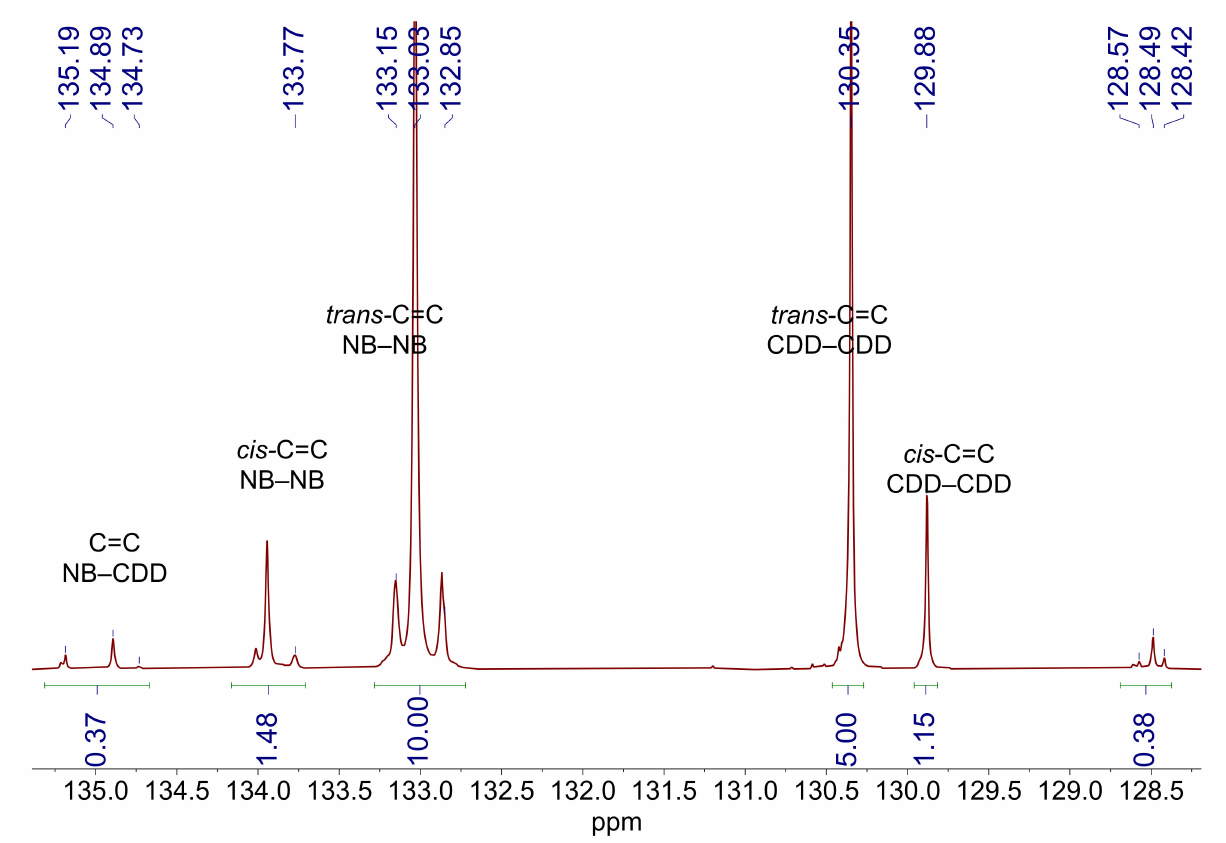
Figure 1. Vinylene region of the 13 C NMR spectrum for C6 NB–CDD copolymer.